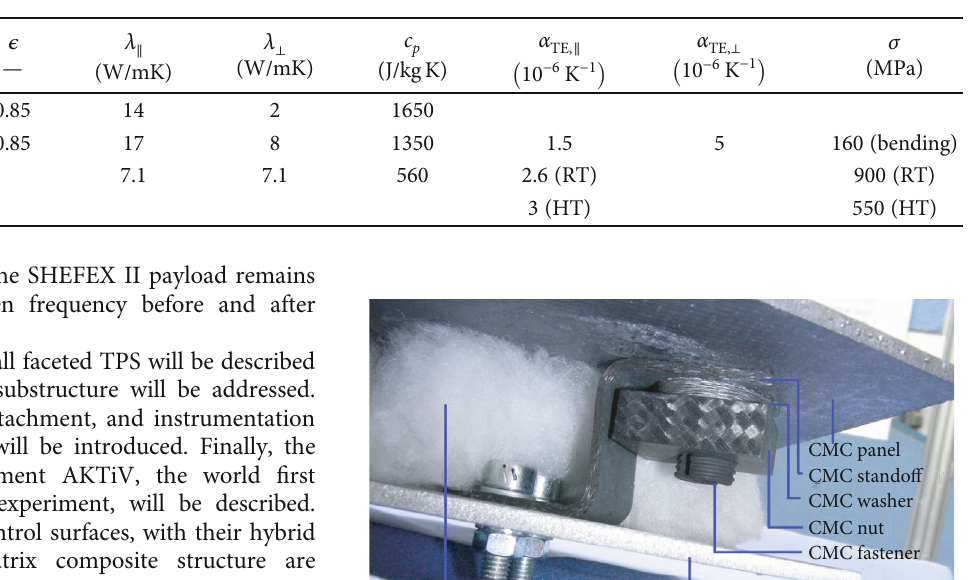
Figure 4: SHEFEX II shock and expansion Table 1: Material properties of C/C, C/C-SiC, and titanium Ti6Al4V. C/C-SiC is given in its orthotropic properties which are comparably constant over temperature. Titanium properties are given with respect to room temperature (RT) and high temperature (HT) of approximately 800K.